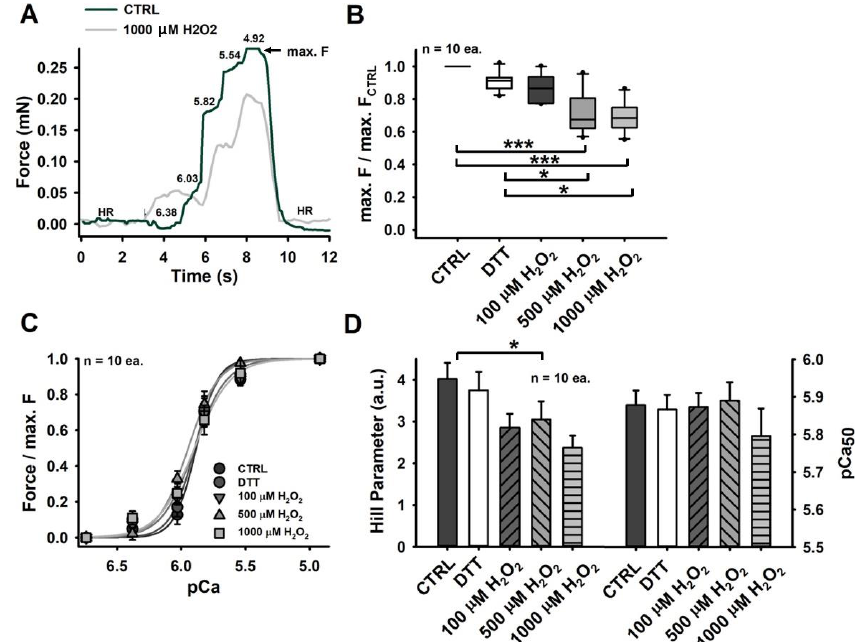
Figure 2. Maximum active forces decline with increasing H 2 O 2 concentration in each single recording sequence. ( A ), example recording of a pCa-force curve at increasing Ca 2+ -concentrations (decreasing pCa). ( B ), maximum force (at pCa = 4.92) declined significantly for fibres exposed to 500 and 1000 µM H 2 O 2 , while a 60 s DTT incubation and exposure to low levels of H 2 O 2 (100 µM) had no significant